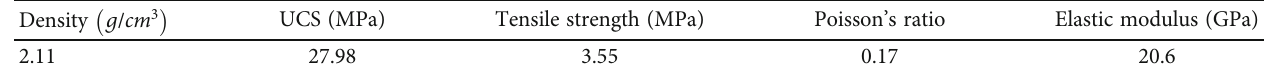
Table 1: Mechanical properties of physical model specimens